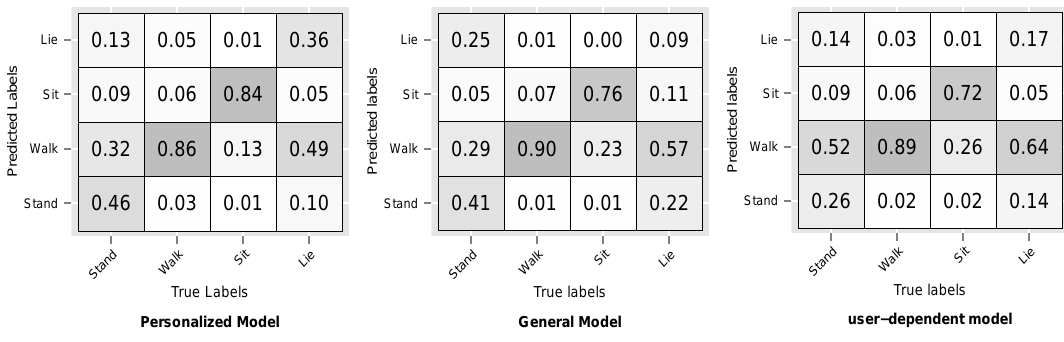
Figure 9. D5: Opportunity dataset Confusion